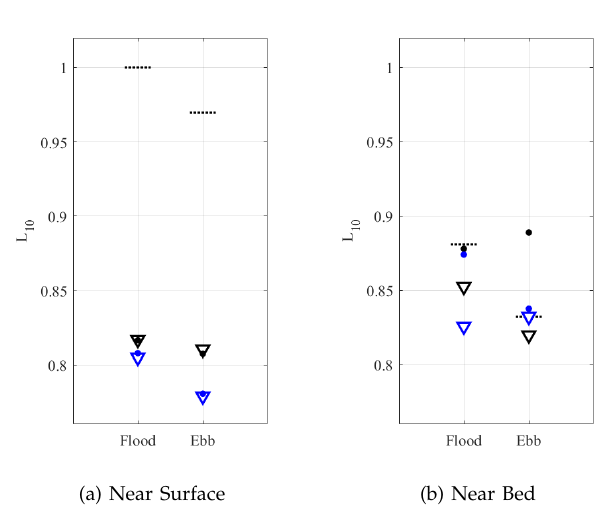
Fig. 7. Normalised damage equivalent loads for one velocity bin (2.2- 2.4 m/s) determined using varying (open triangle) and mean (solid dot) measured profiles (black) and predicted profiles (blue) using a constant value for the fluctuation intensity, dashed lines to represent the measured varying case with varying fluctuation intensity.